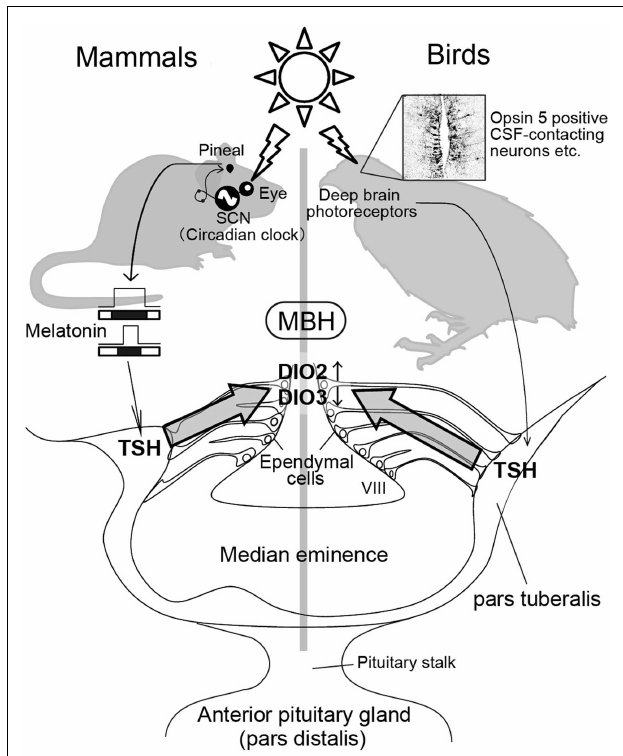
FIGURE 2 | Photoperiodic signal transduction pathway in mammals and birds . In mammals, light information is received by the eye and transmitted to the pineal gland via the circadian pacemaker, the suprachiasmatic nucleus (SCN).The duration of the pineal melatonin signal encodes the length of night and regulatesTSH secretion in the pars tuberalis.The pars tuberalisTSH acts onTSH receptor expressed in the ependymal cells lining ventrolateral walls of the third ventricle (VIII) to induce DIO2 and reduce DIO3. Local thyroid hormone activation within the mediobasal hypothalamus (MBH) by DIO2/DIO3 switching plays a key role in the regulation of seasonal reproduction. In contrast, light information received by deep brain photoreceptors inducesTSH secretion from the pars tuberalis in birds. Nevertheless, melatonin is not involved in the seasonal reproduction of birds.The schematic is a modified version of illustration published by Ikegami andYoshimura